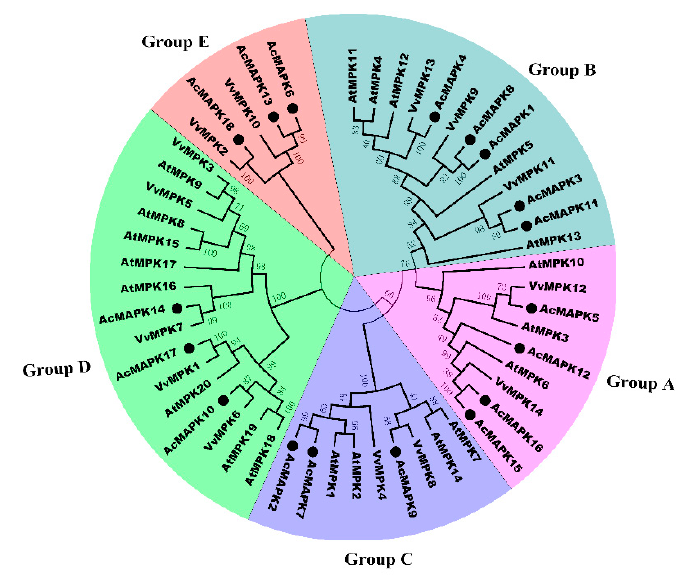
Figure 1. Phylogenetic relationship of putative MAPK genes in Arabidopsis chinensis , V. vinifera , and A. thaliana . The phylogenetic tree was created using MEGA5.0 program with the neighbor-joining (NJ) method. Bootstrap values for 1000 replicates are indicated at each branch. Letters A–E indicate different groups of MAPKs.